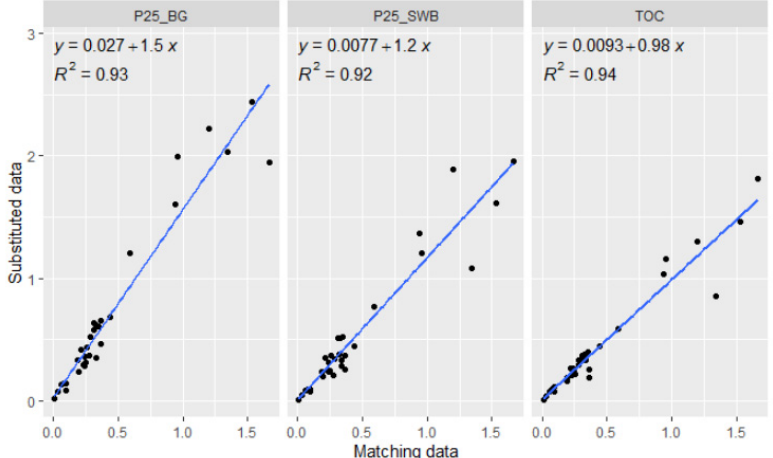
Figure 7. The comparison of the BIO-MET calculated RCR for Zn between the matching data and substituted data (P25_BG—the 25th percentile of the available DOC data and/or the DOC data calculated by the TOC from the Bulgarian monitoring network results during 2020; P25_SWB—the 25th percentile of the DOC data calculated by the TOC for the respective water body; TOC—the matching DOC data calculated by